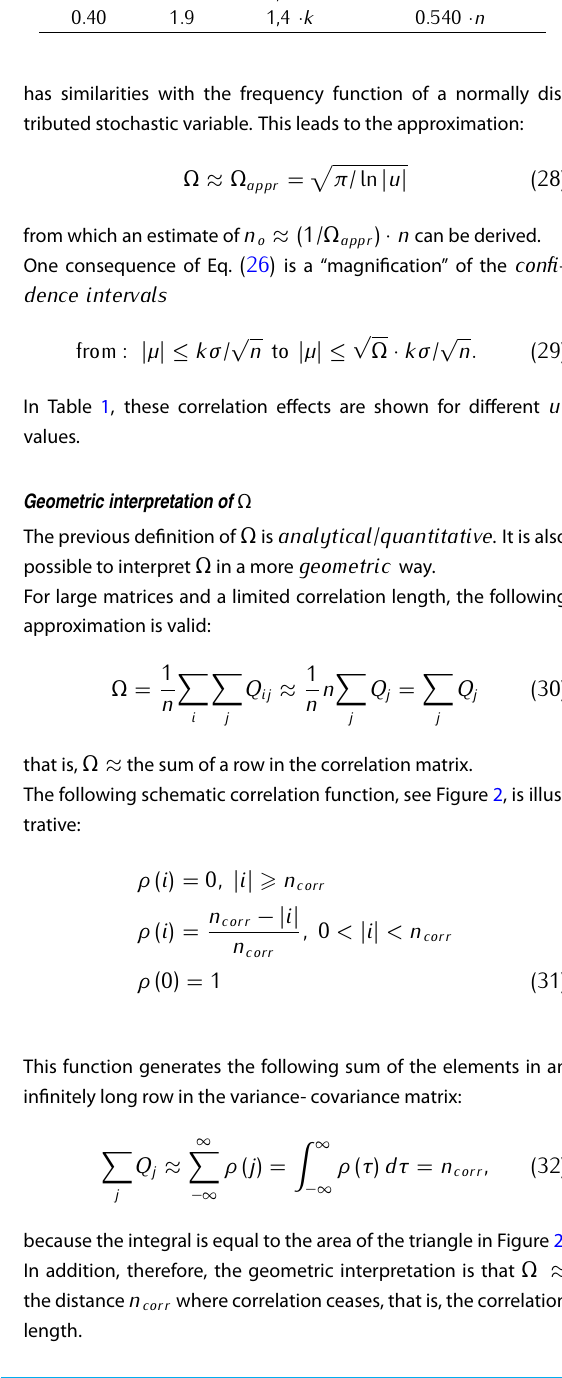
Figure 1. “Gaussian correlation function” (left) and “First-order Gauss-Markov correlation function”(right).